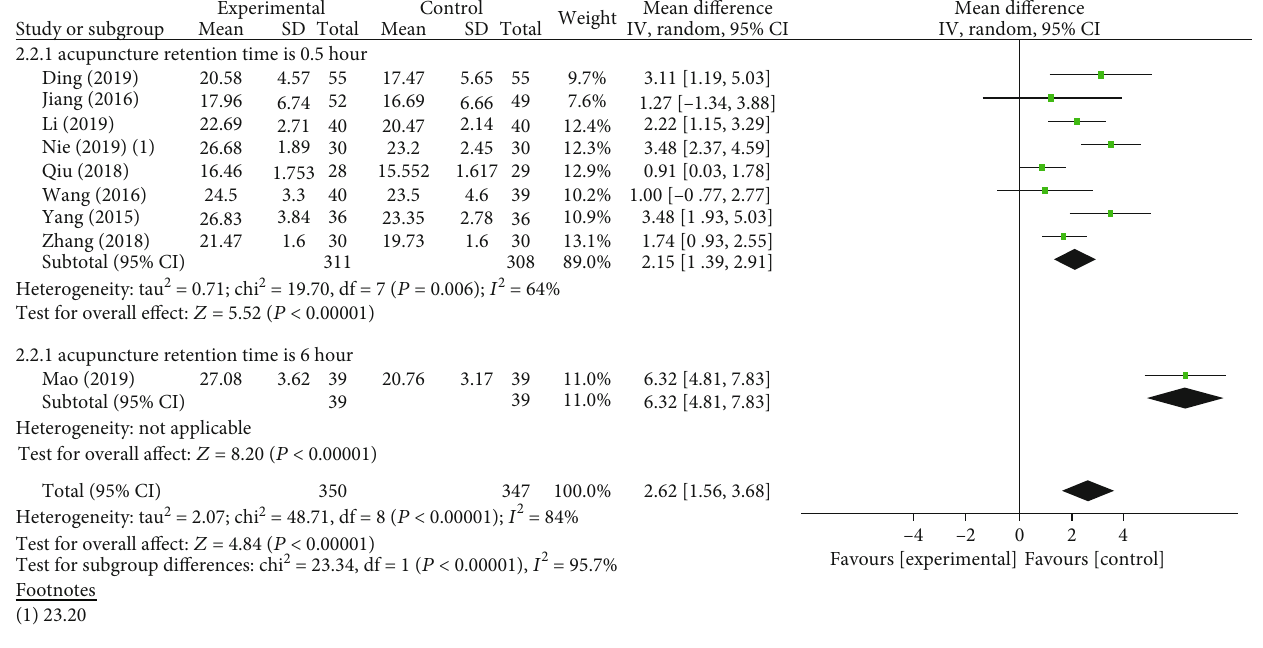
Figure 6: The forest plots of MoCA.